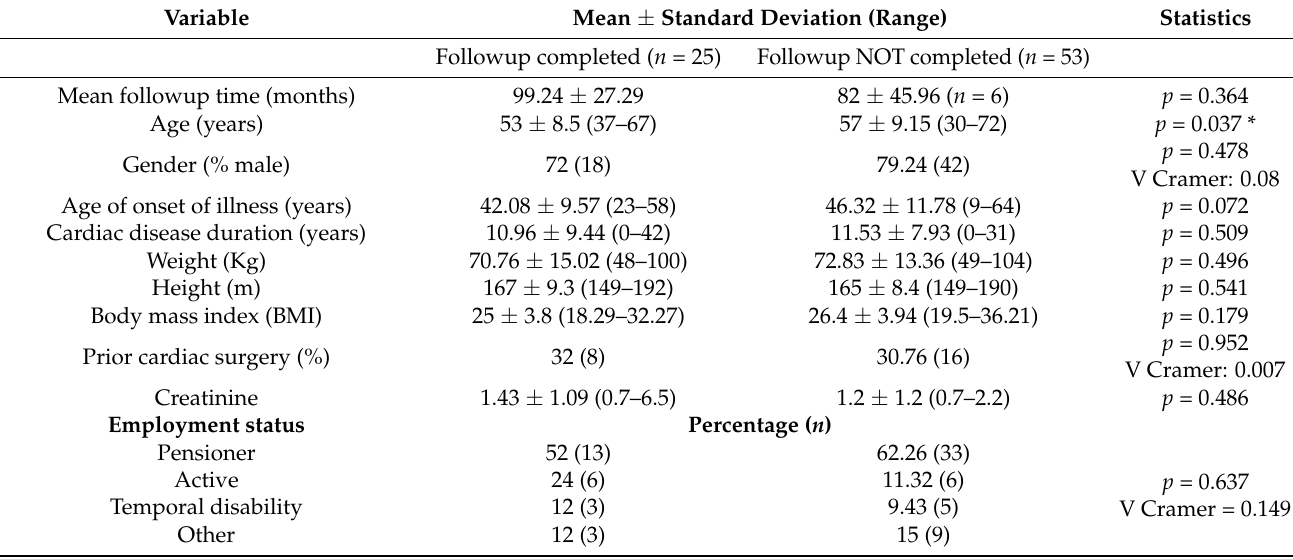
Table 1. Epidemiological and clinical